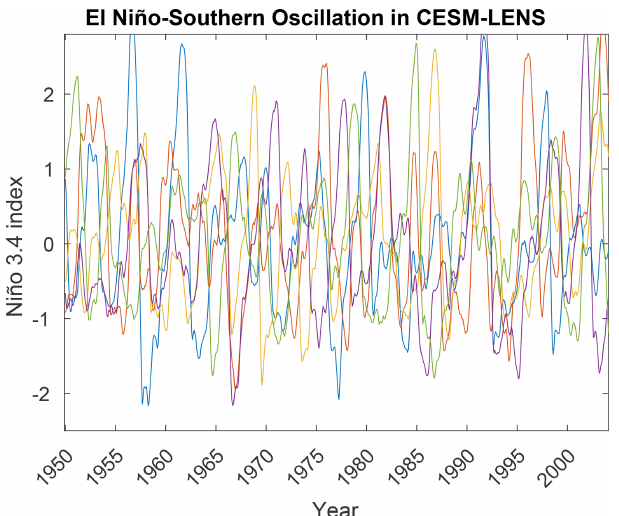
Figure 3. Example of the different realizations of ENSO, as de- fined by the NINO3.4 index, in a version of CESM. For compari- son, a subset of only 5 of 35 available realizations is shown using different colours which demonstrate vastly different ENSO condi- tions in realizations differing based on perturbed initial atmospheric